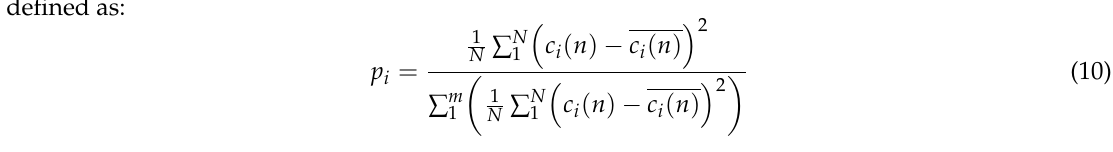
Table 4. intrinsic mode function (IMF) energy for different conditions.